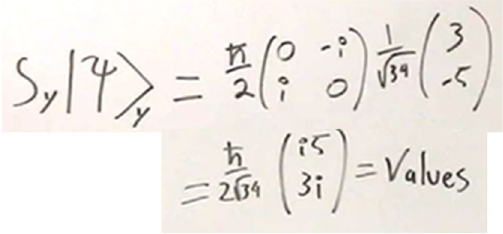
FIG. 4. Calleigh ’ s attempt at the summation method where she identifies that values and probabilities are needed but expressed the values as the results of a